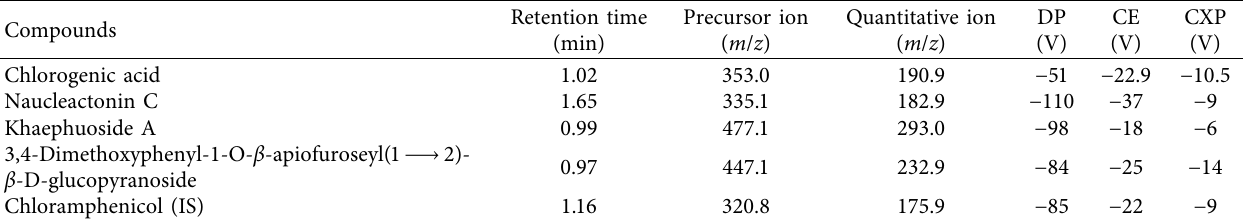
Table 1: Optimized multiple reaction monitoring parameters for the detection of four analytes and